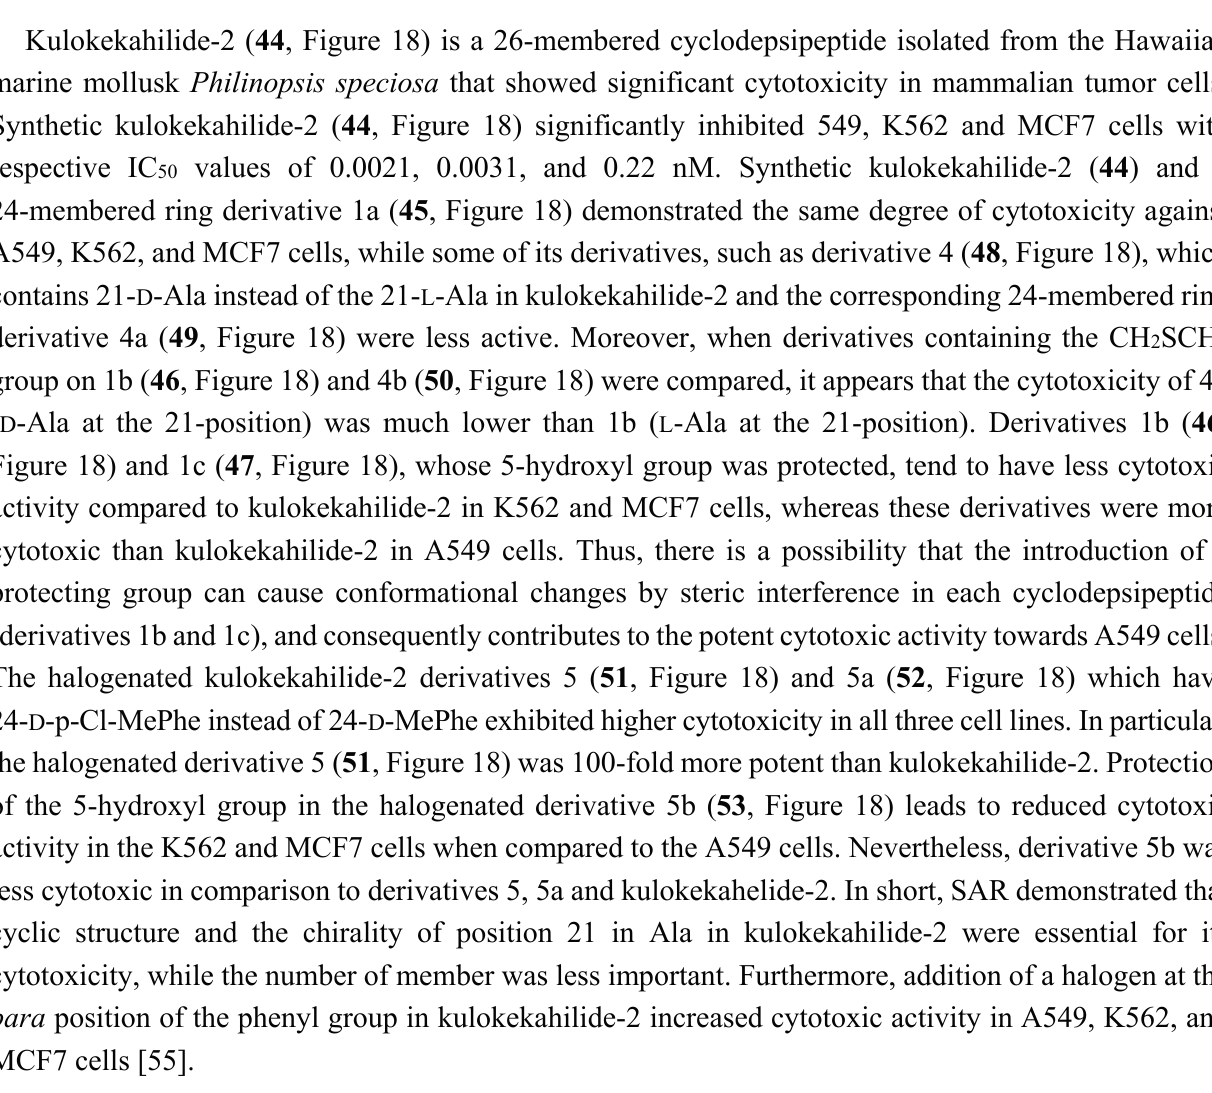
Figure 17. Pipestelides A, B,